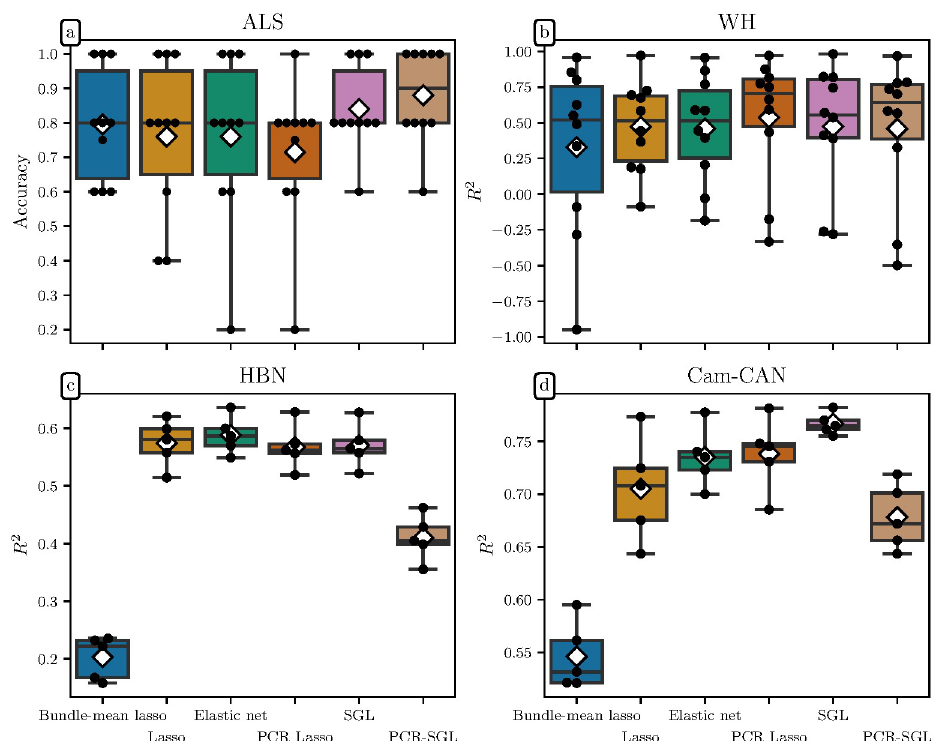
Fig 4. Model performance across all datasets. Each panel shows model performance measured on the test set for each cross-validation split, with each black dot representing a split, box plots representing the quartiles, and white diamonds representing the mean performance. The y -scale varies in each subplot. (a) Accuracy of test set predictions for the ALS dataset. Because group differences in ALS diagnosis are mostly confined to a single bundle, the group structure- preserving methods, SGL and PCR-SGL, outperform the other models. The remaining frames show coefficient of determination, R 2 in test sets for the (b) WH, (c) HBN, and (d) Cam-CAN datasets. Because aging affects the white matter globally, group structure-blind methods like elastic net and PCR Lasso perform well. Nonetheless, the SGL models show competitve predictive performance, adapting to a problem where group structure is not as informative. PCR-SGL performs poorly in this regime because its initial group-wise PC projection destroys between bundle covariance. The bundle-mean lasso performs poorly, demonstrating the value of along-tract profiling.